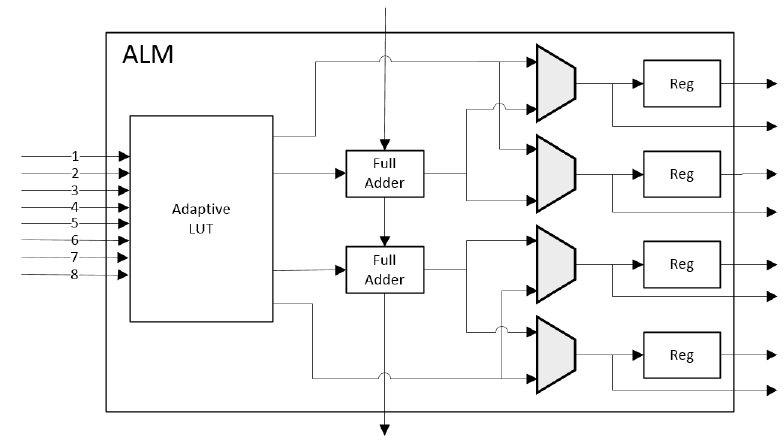
Figure 8. Design of the ALM unit in the Cyclone V system [24].